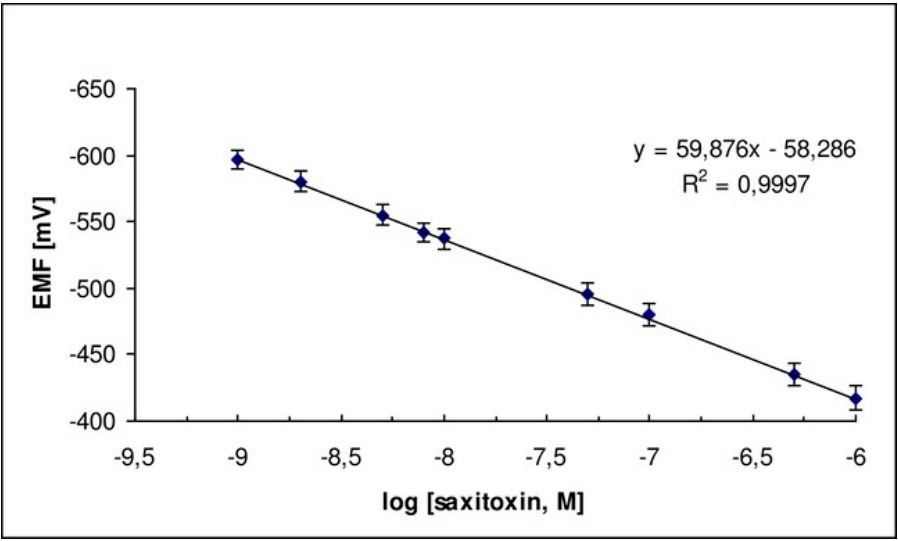
Figure 8. Calibration graph for STX determination using the saxitoxin potentiometric biosensor [from ref. [24] with